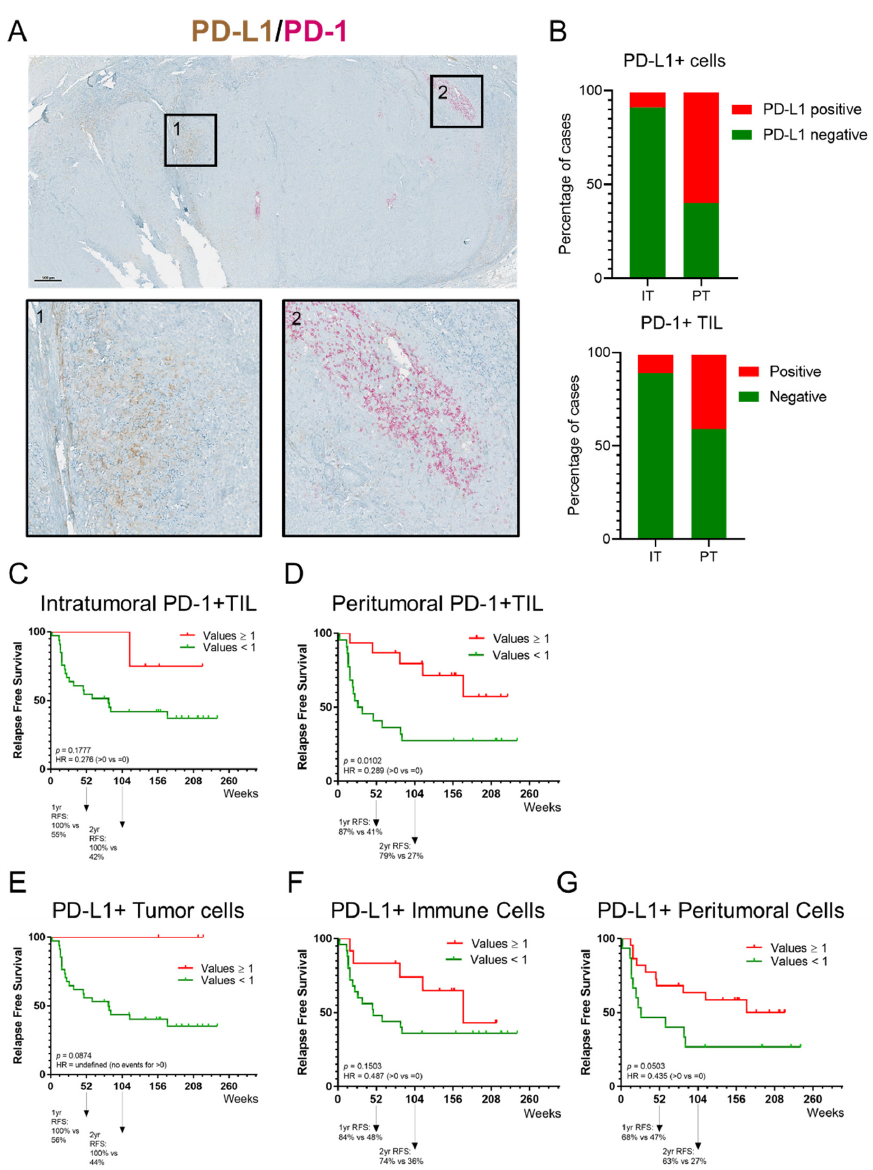
Figure 4. Prevalence of PD-1 and PD-L1 expression on cells in melanoma metastases and their potential correlation with the immune infiltrate evaluated using a dual IHC stain. ( A ) Representative image of a tissue section of a melanoma metastasis stained for PD-1 and PD-L1; shown here are an overview of the section and two regions of interest. Region 1 shows PD-L1 + cells; region 2 shows peritumoral PD-1 + TIL. IHC slides were scanned at × 40 magnification and the images are displayed at × 2.2 (Scale bar = 500 µ m) and × 10 magnification. ( B ) Box plot displaying the percentage of intratumoral and peritumoral PD-1 + TIL and PD-L1 + cells. A percentage of 59.5% and 40.5% of melanoma metastases, respectively, contained PD-L1 + cells and PD-1 + TIL in the peritumoral area (threshold of ≥ 1% positive cells). PD-L1 + cells and PD-1 + TIL in the intratumoral area were detected in only 8.1% and 10.8%, respectively. ( C , D ) Kaplan–Meier estimates of RFS. Presence of peritumoral PD-1 + TIL was significantly associated with a longer RFS; intratumoral PD-1 + TIL were not associated with improved RFS. ( E – G ) Kaplan–Meier estimates of RFS. No significant association in RFS was observed for PD-L1 + tumor cells, and PD-L1 + peritumoral